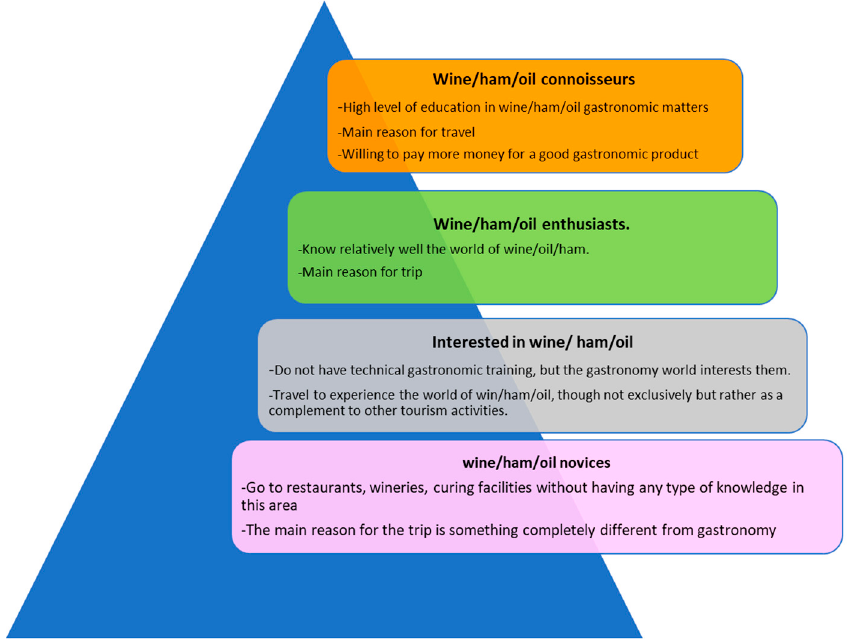
Figure 6. Classification of the gastronomic tourist according to product. Source: own elaboration